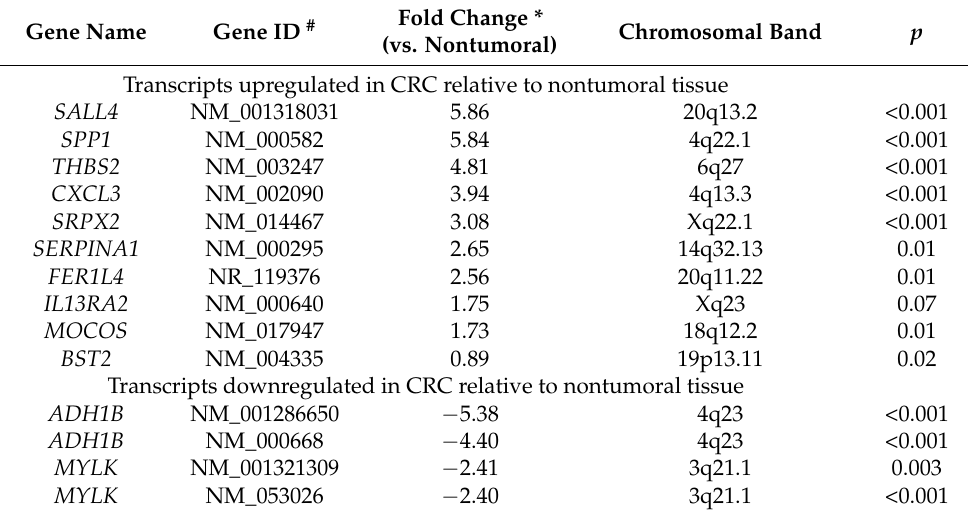
Figure 1. Classification of sCRC tumours and nontumoral colorectal tissues based on the gene expression profile (GEP) of the most strongly dysregulated transcripts. Biplot analysis of 66 primary colorectal tumours (red triangles) vs. 10 nontumoral colorectal tissue samples (blue circles). Table 2. Statistically significant mRNA dysregulated in sCRC patients (n = 66) relative to nontumoral colorectal tissues (n =